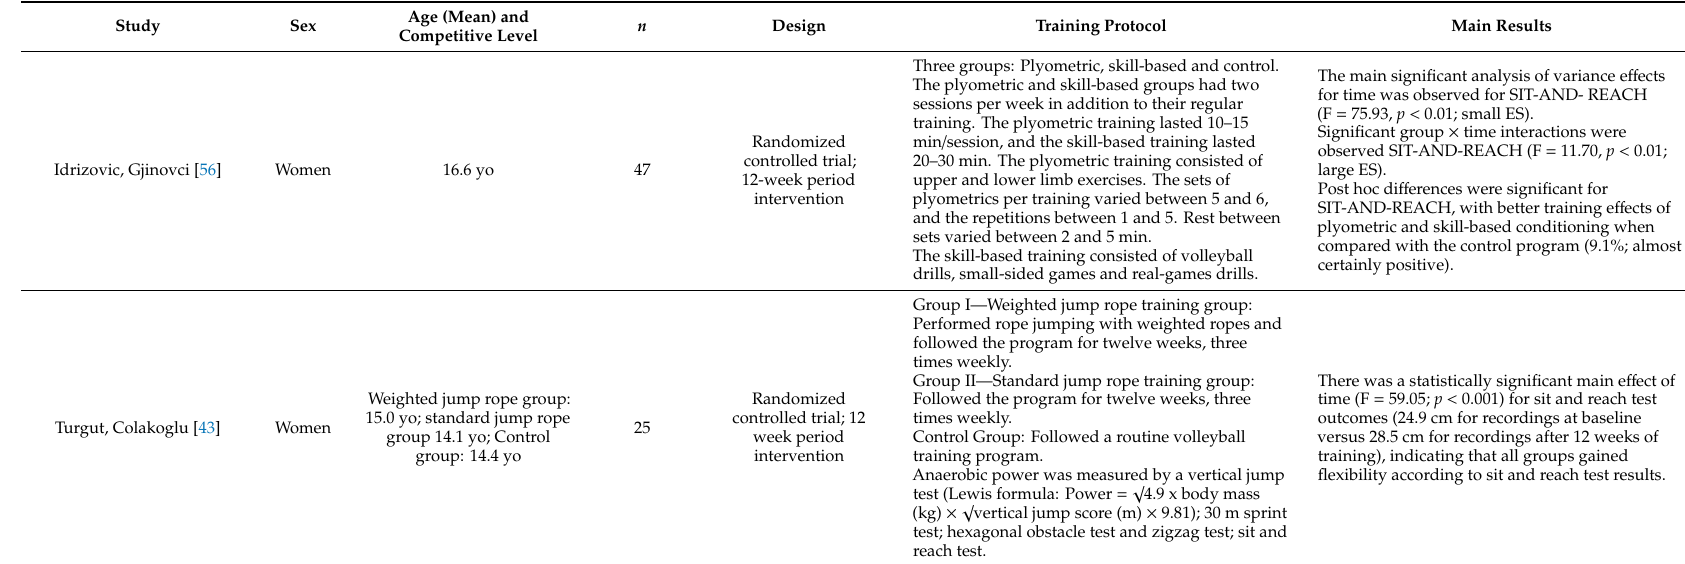
Table 5. Studies that investigated the e ff ects of plyometric training programs on